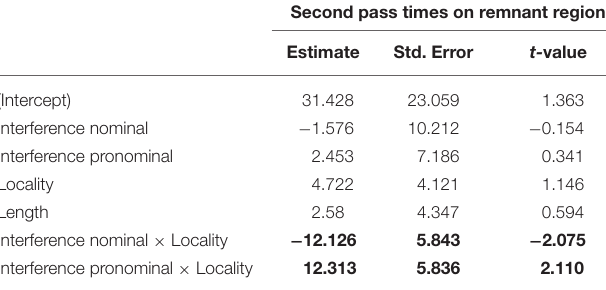
TABLE 9 | Experiment 2: Structure-Dependent Interference effects in second pass re-reading times on the remnant